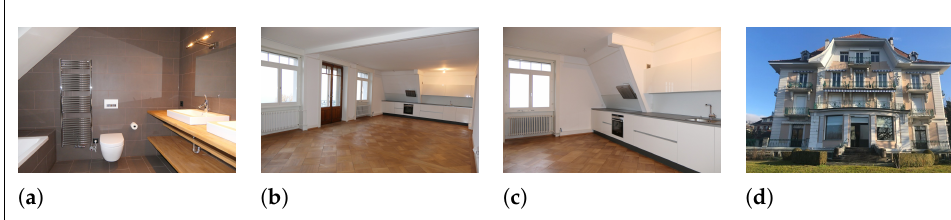
Figure 3. Example of four commonly found room types after executing stage three. The demonstrated room types are bathroom ( a ), living room ( b ), kitchen ( c ), and exterior ( d ).